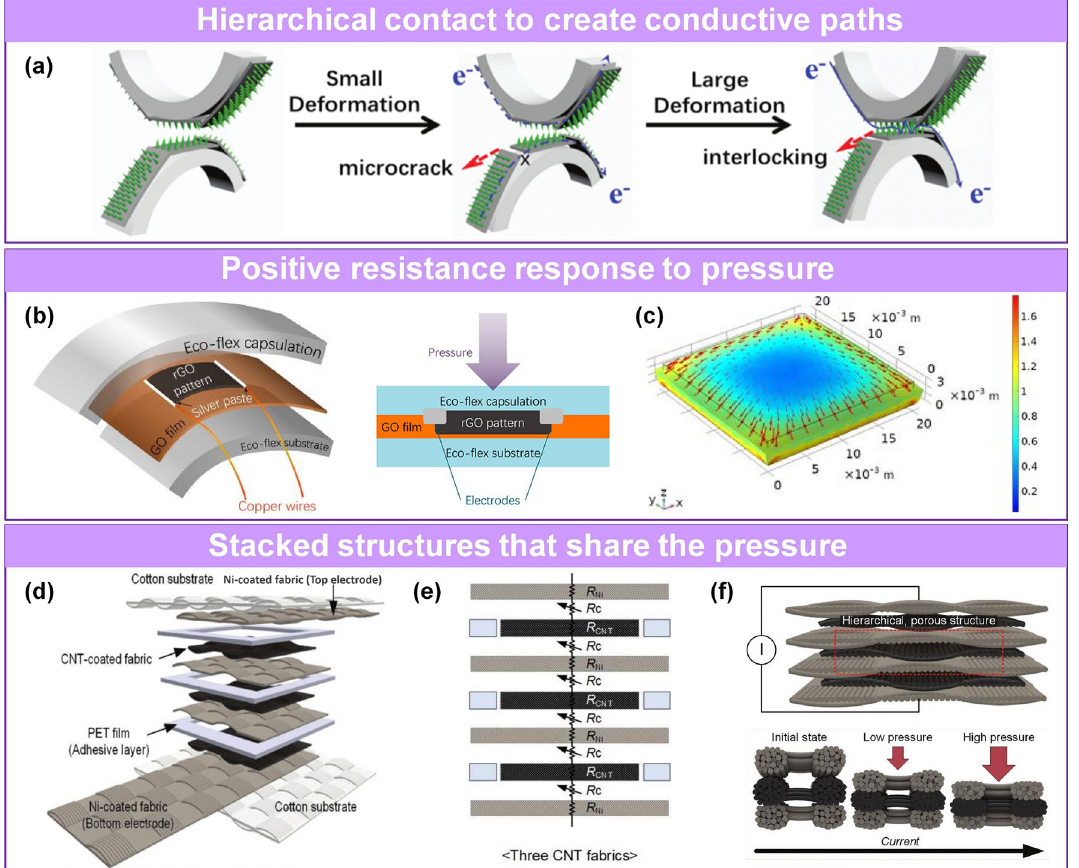
Fig. 8 Pressure sensors with broad working range and stable sensing performance. a Schematic illustration of pressure sensor with microcrack and interlocking structure [35]. Copyright (2018) Wiley–VCH. b Device structure and c compression simulation of positive resistance